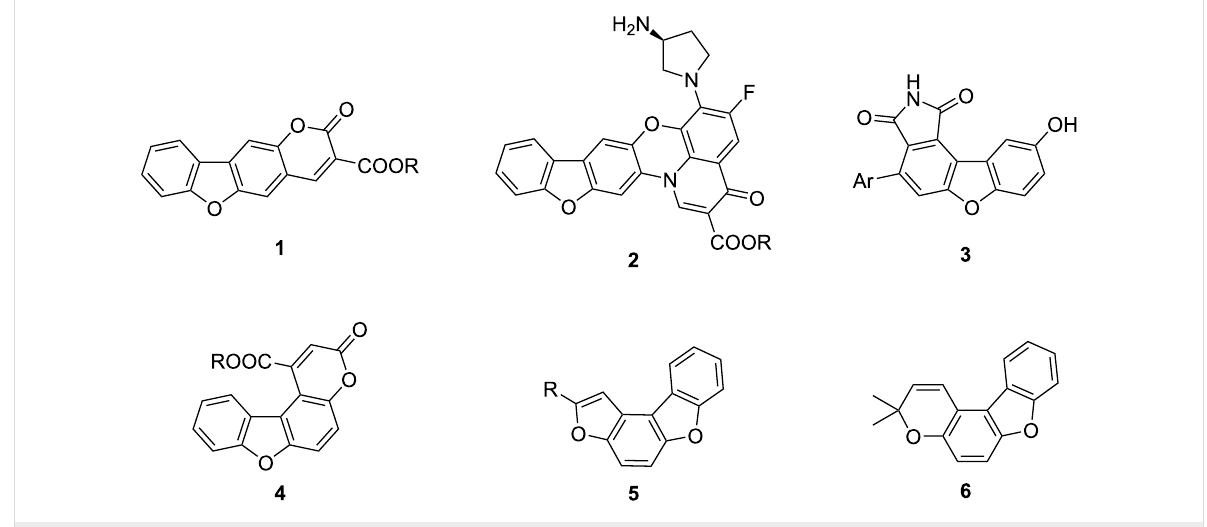
Figure 1: Biologically relevant 2-oxydibenzofuran-containing structures 1 – 6 .